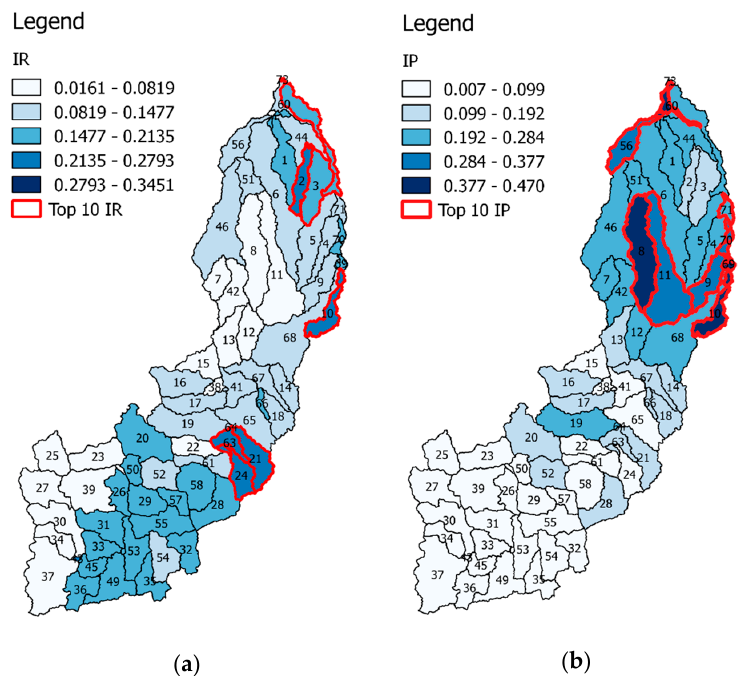
Figure 6. Spatial distribution of watershed indices: ( a ) I R and top 10 sub-basin for I R ; ( b ) I P and top 10 sub-basin for I P .